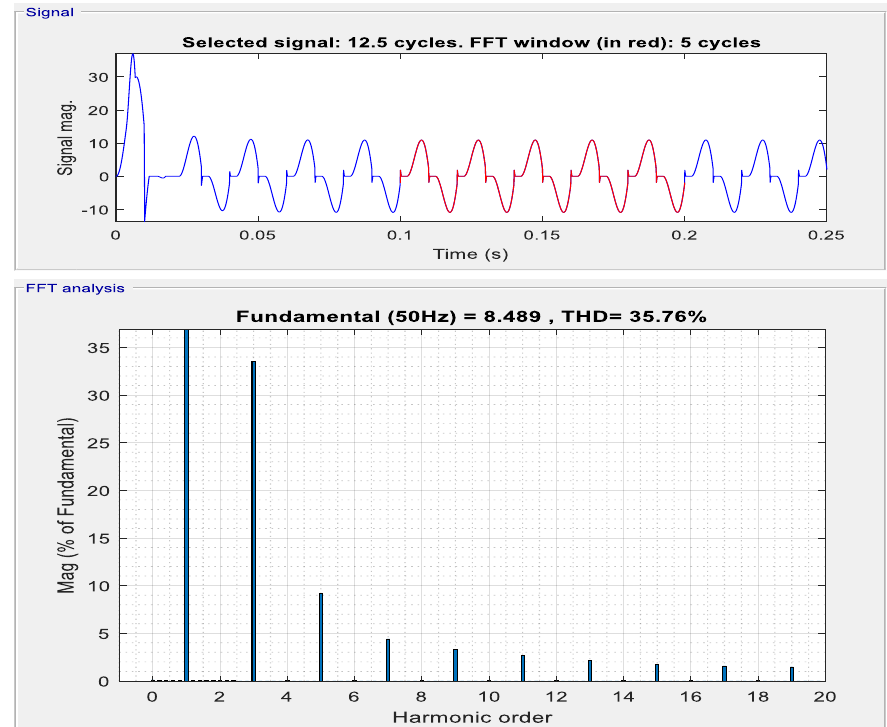
Figure 26. %THD of Source Current without Harmonic Filter.